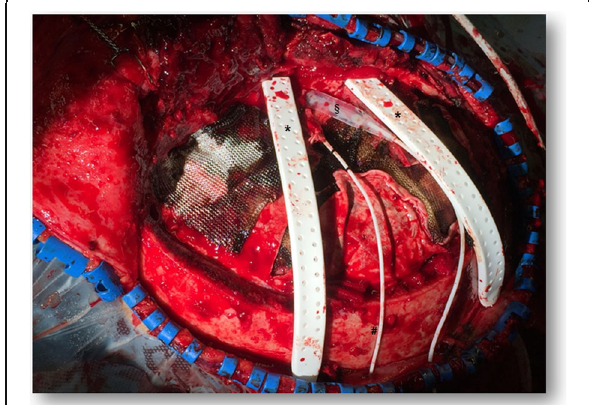
Fig. 2 Intraoperative situs after the evacuation of acute subdural hematoma and insertion of two Jackson – Pratt drains (*), intracranial pressure probe (#) and frontotemporally placed subdural EEG electrode